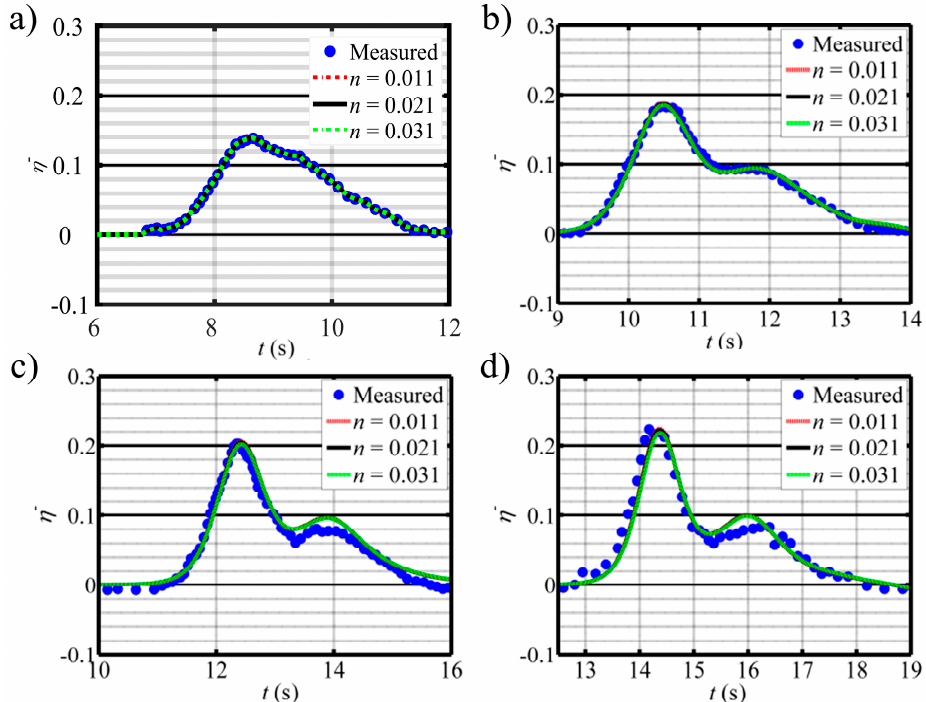
Figure 4. Comparison between measured and simulated waveforms with different Manning roughness at x = ( a ) 10 m, ( b ) 14 m, ( c ) 18 m, and ( d ) 22 m.